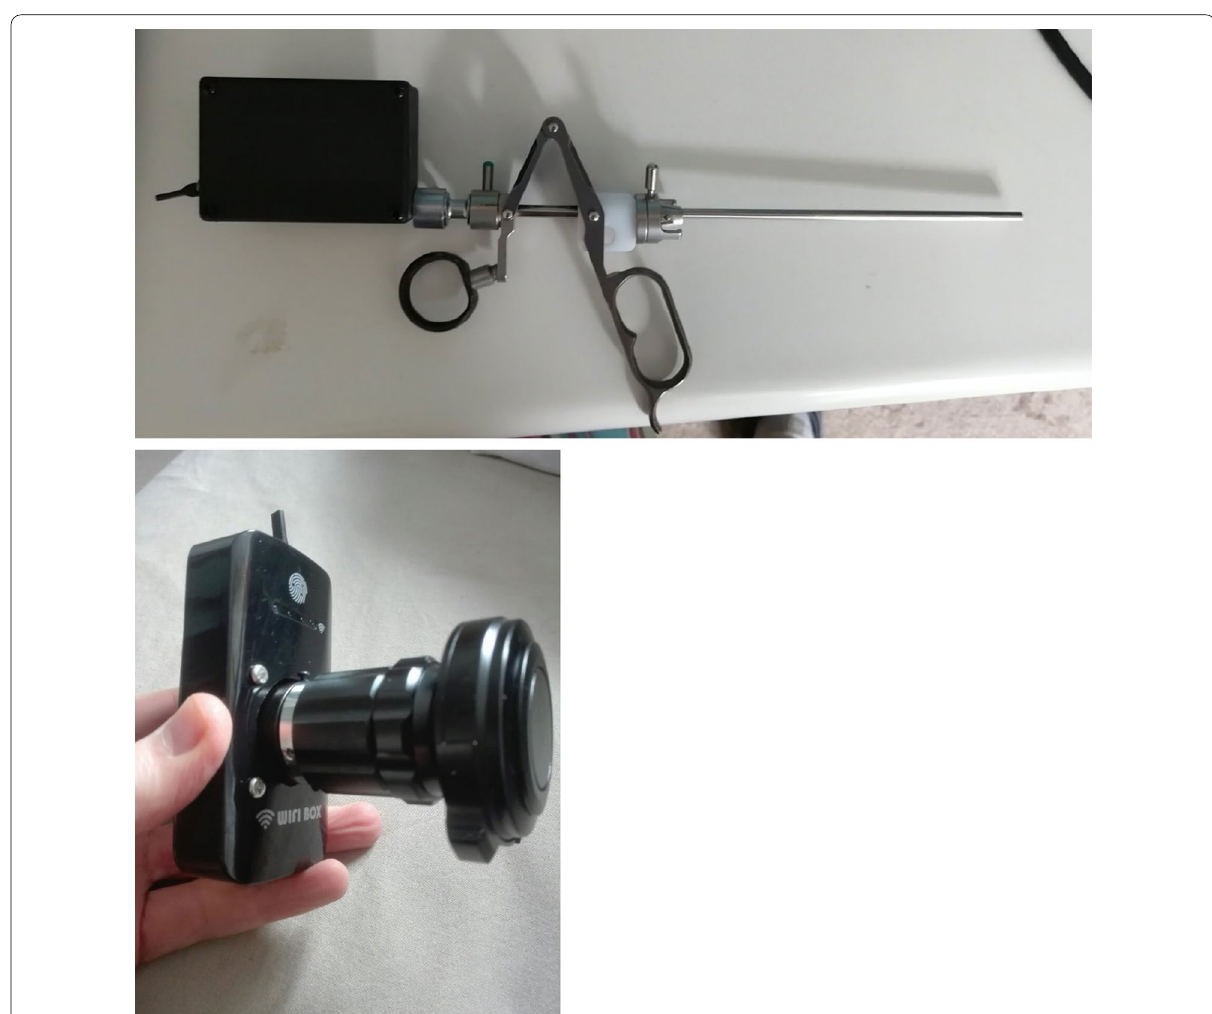
Fig. 3: 4 mm wireless cystoscope camera attached to a working element of a resectoscope (top). Wireless camera with optical coupler